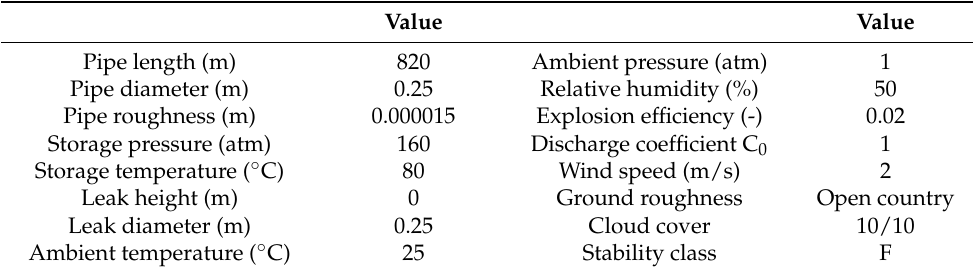
Table 3. Summary of data used for the calculations.